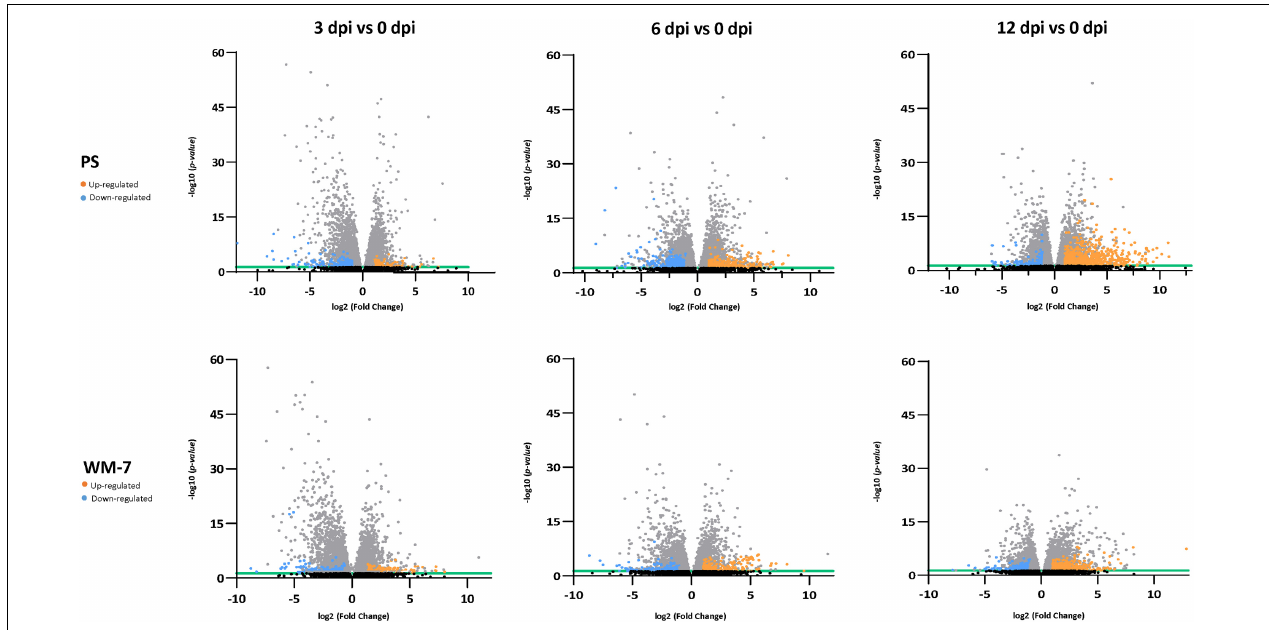
FIGURE 3 | Volcano plots display DEG distribution for each time point at 3, 6, and 12 dpi in both PS and WM-7. Orange dots represent the upregulated genes and blue dots downregulated genes. The x -axis correspond to log2 (fold change) and the y -axis to –log10 ( p -adjusted). Black dots represent those DEGs not considered significant with p -adjusted ≥ 0.05 (green line shows the cutoff) and gray dots those DEGs differing from mock-inoculated treatments in 1.5 < log2 (fold change) > 1.5.